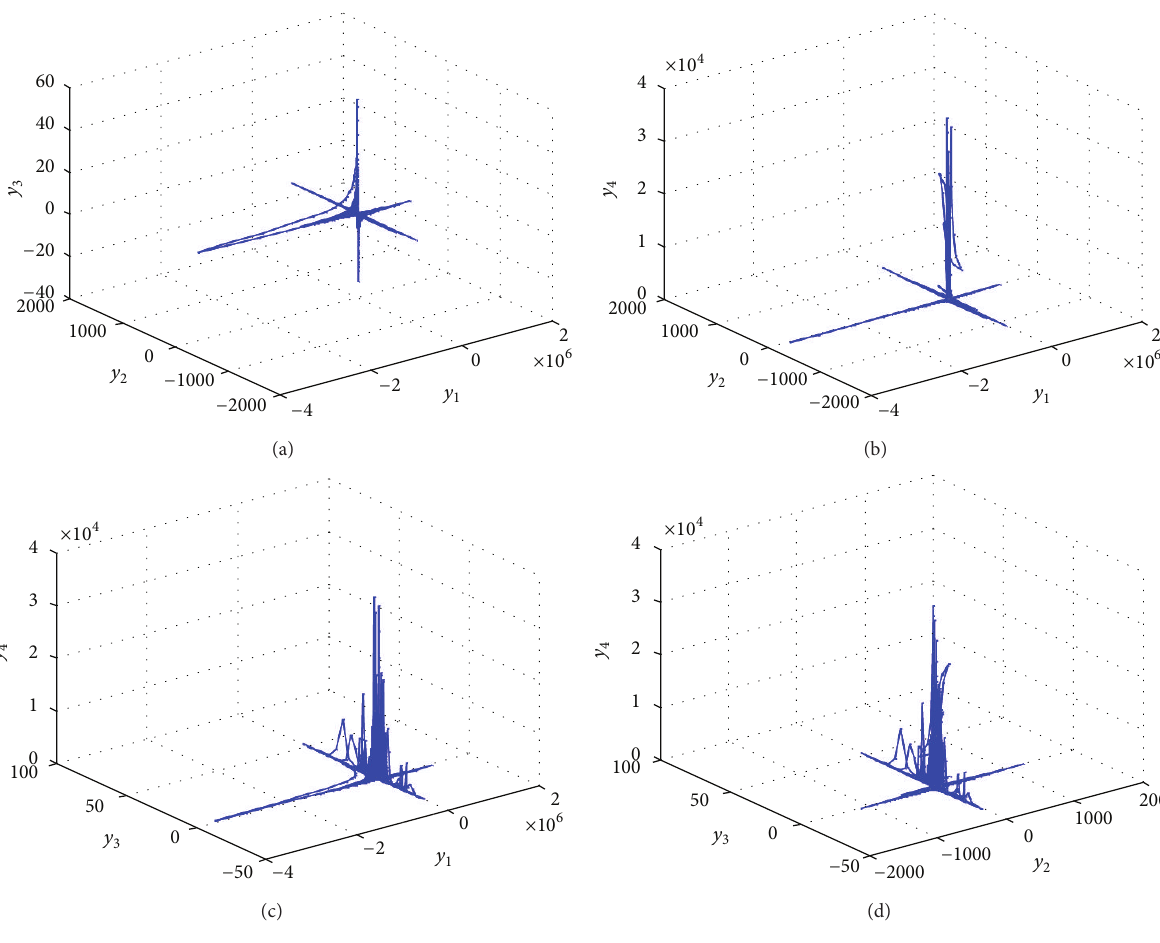
Figure 5: Projections of the phase portrait for chaotic system (13) of Case